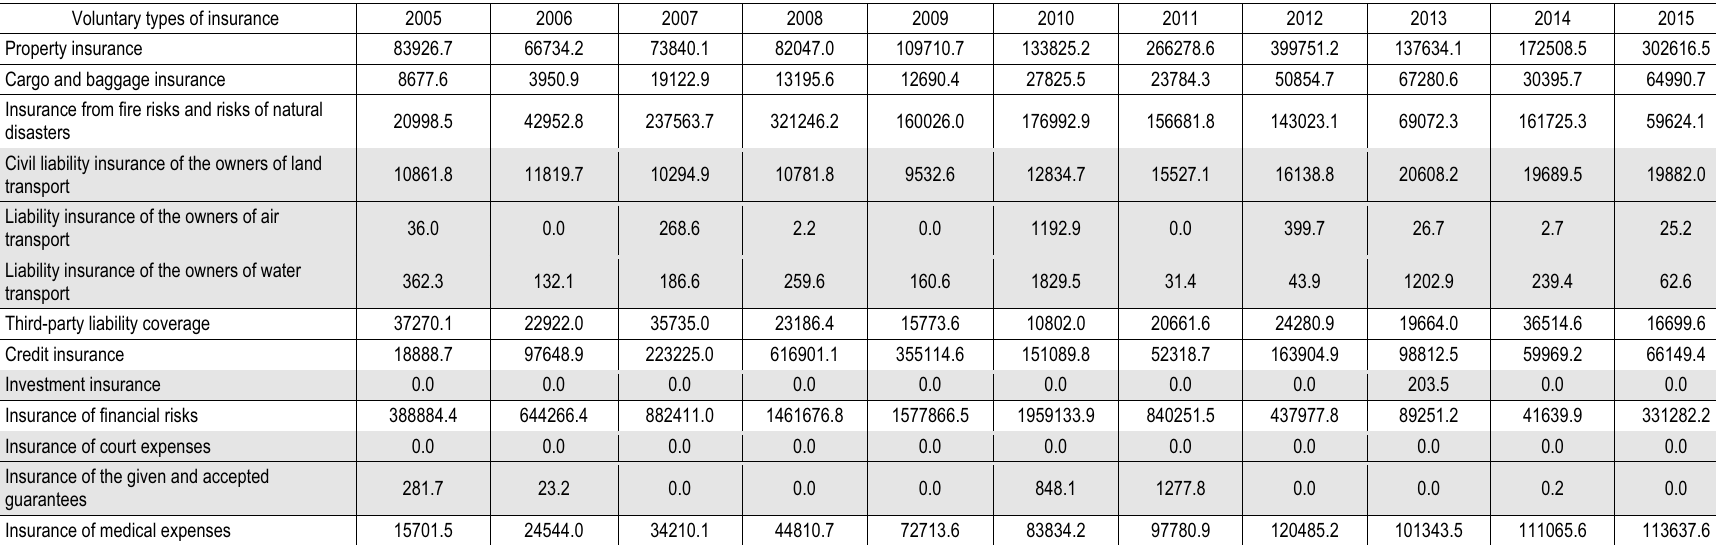
Table 2 (cont.). Net insurance payments for certain types of insurance in 2005-2015, thousand UAH.